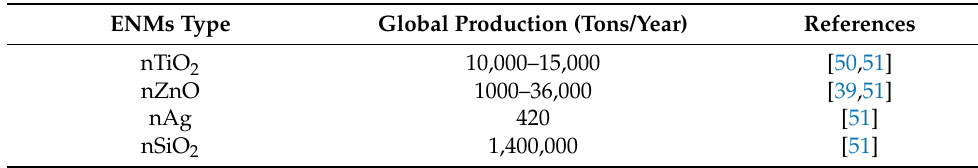
Table 1. The global production and application of selected engineered nanomaterials (ENMs) based on beneficial